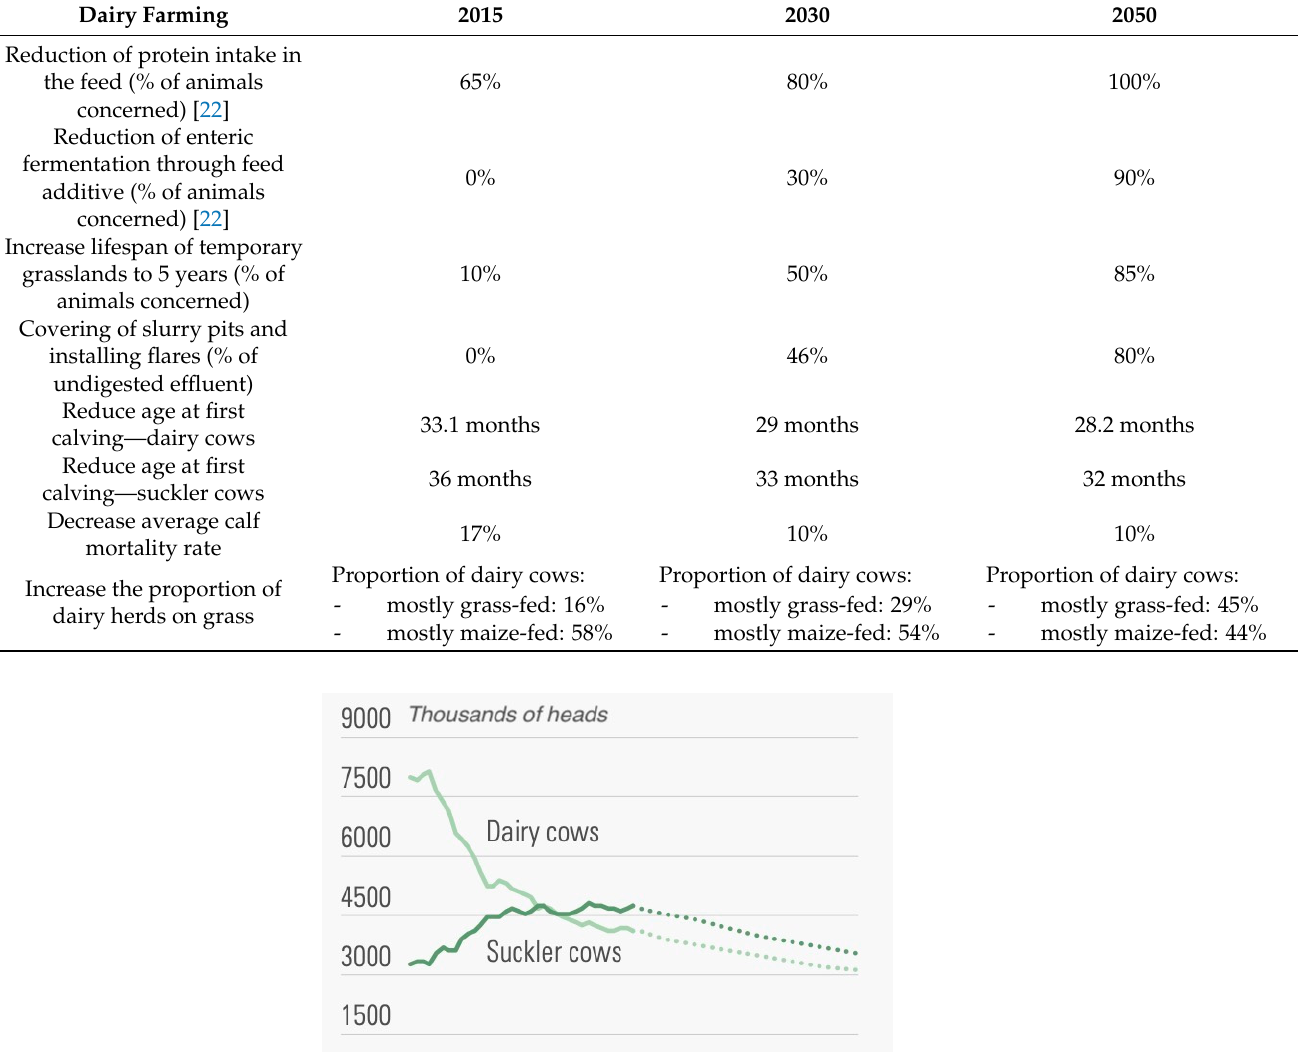
Table 1. Technical developments in livestock systems according to SNBC assumptions (Source: adapted from MTES, 2020 [20]).